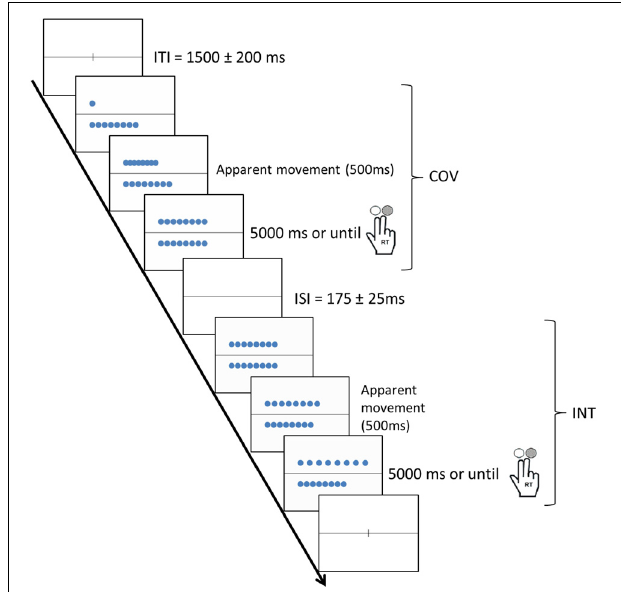
FIGURE 2 | Procedure used in the number-conservation task when the COV stimulus was presented first. The COV and INT stimuli both involved an apparent movement (500ms) that started at the stimulus onset. Note that all participants provided their responses by pressing the “yes” or “no” buttons on the response box with the forefinger and middle finger of their right hand and that COV and INT stimuli remained on the screen until participants provided an answer (or for 5000ms if participant did not press one of the two